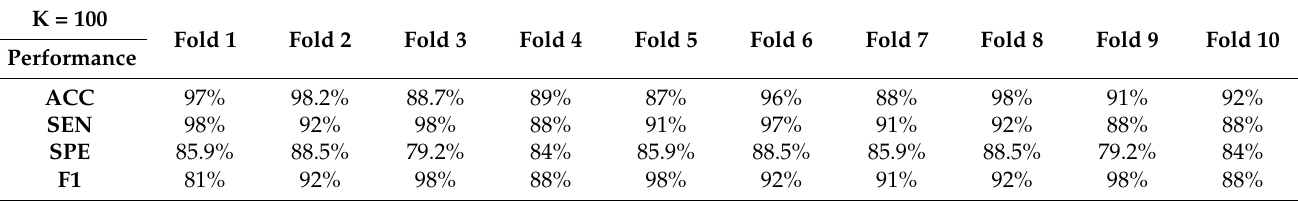
Table 7. The suggested method’s performance metrics after being subjected to ten-fold cross- validation with the SVM